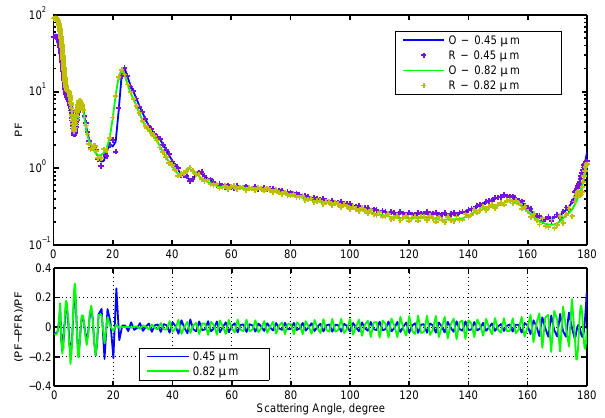
Fig. 2. Upper panel: phase functions in the shortwave at 0.45 µm: Original (PF, blue line) and Reconstructed (PFR, purple crosses); PF at 0.82 µm: Original (green line) and Reconstructed (olive green crosses). Lower panel: fractional difference computed as (PF- PFR)/PF.